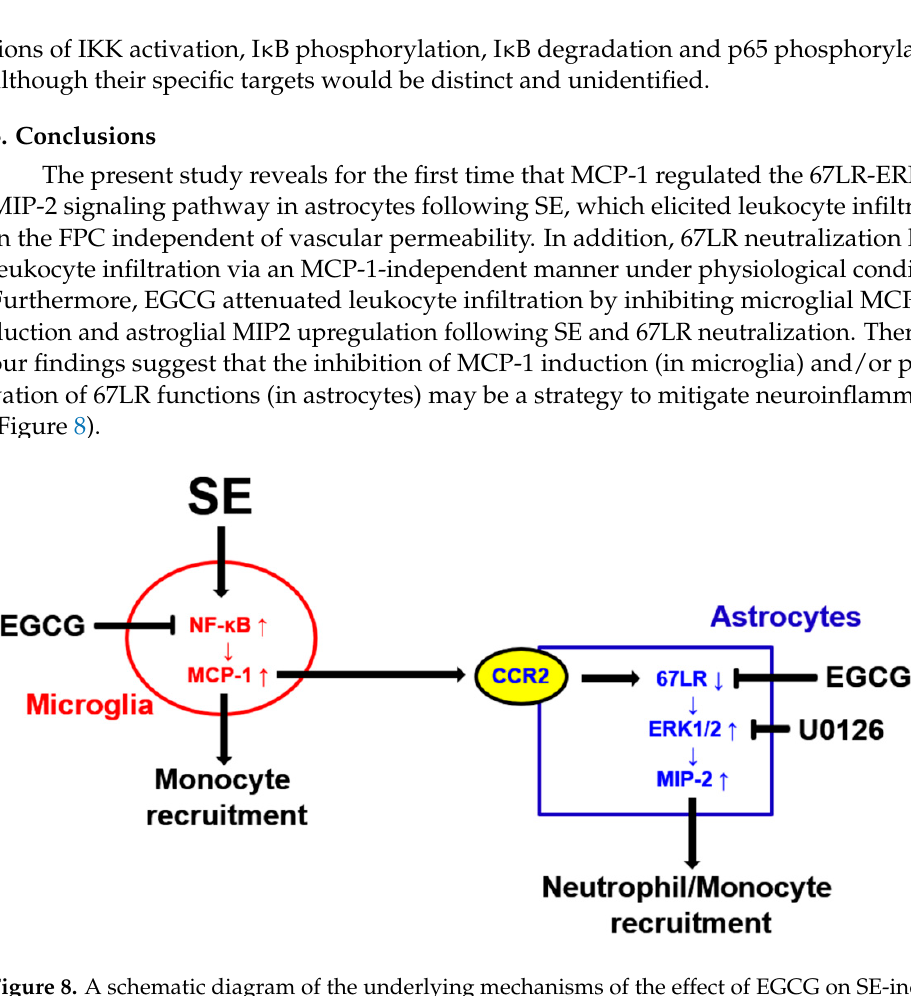
Figure 8. A schematic diagram of the underlying mechanisms of the e ff ect of EGCG on SE-induced leukocyte in fi ltration. SE led to NF- κ B-mediated MCP-1 induction in microglia, which was a tt enu- ated by EGCG. Released MCP-1 from microglia recruited blood-derived monocytes and activated MIP-2 upregulation in astrocytes via the CCR2-67LR-ERK1/2 signaling pathway. EGCG and U0126 also a tt enuated MIP-2 induction in astrocytes by facilitating 67LR-mediated ERK1/2 inactivation, which ameliorated neutrophil/monocyte in fi